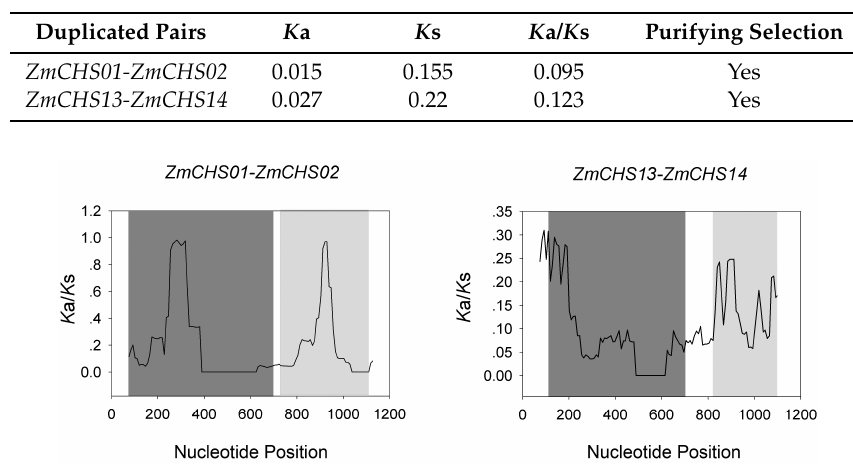
Figure 5. Sliding window plots of duplicated CHS genes. The gray blocks, from dark to light, indicate the positions of the Chal_sti_synt_N domain and Chal_sti_synt_C domain, respectively. The window size was 150 bp and the step size was 9 bp.